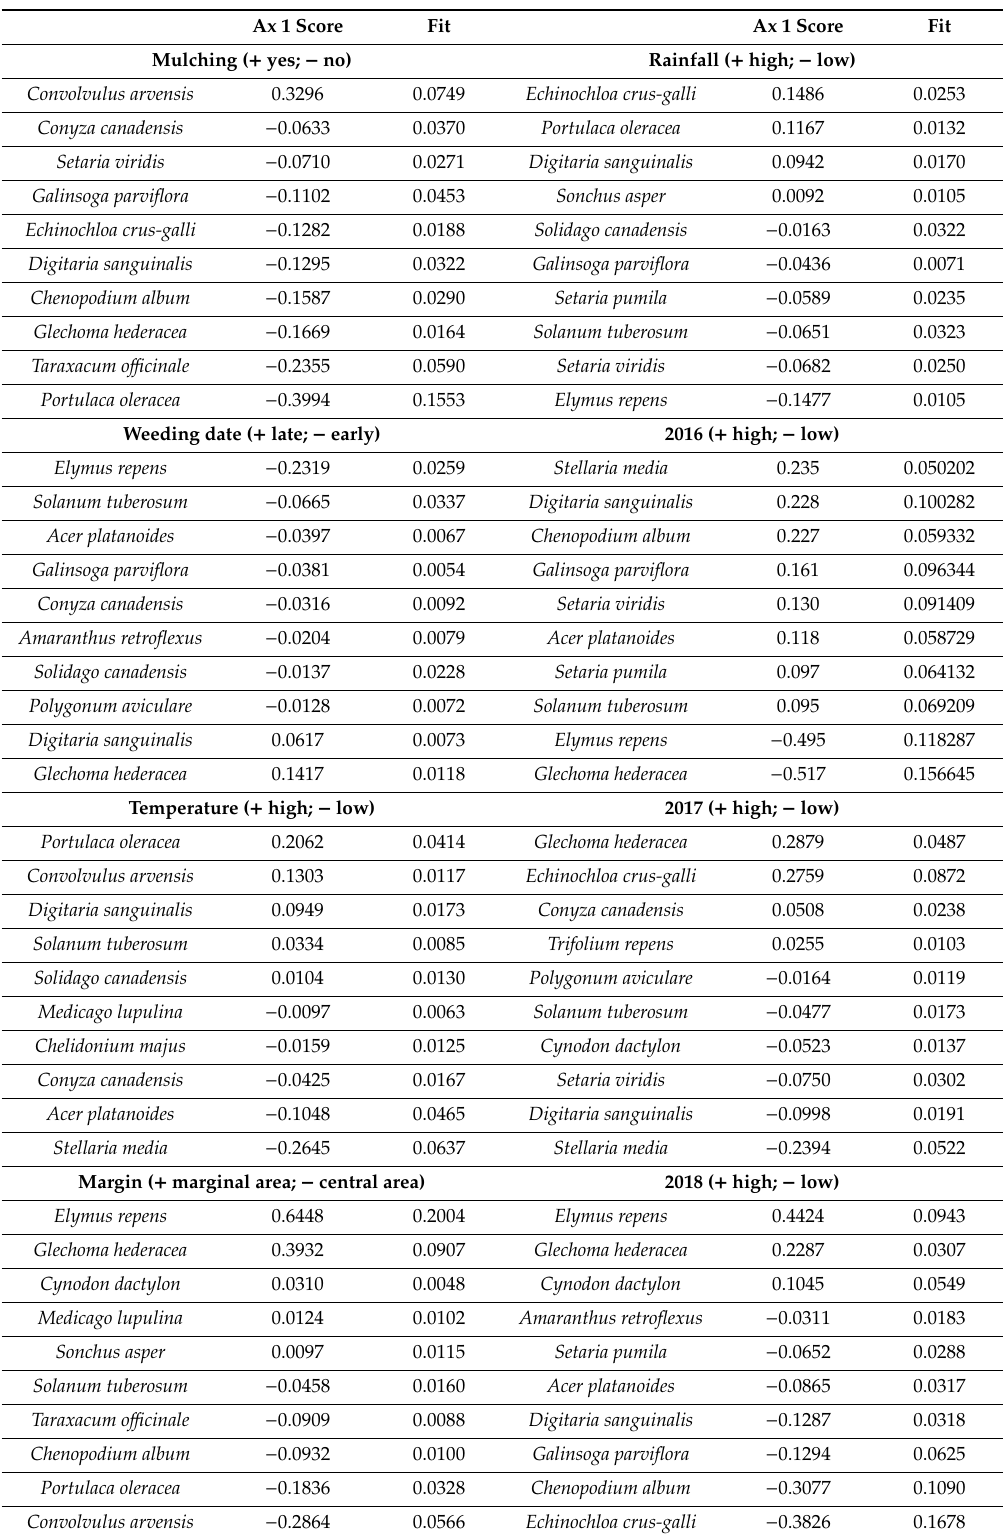
Table 2. Names, score values and fit of species giving the highest fit along the first constrained axis in the partial redundancy analysis (pRDA) models in an open-field tomato experiment (Gödöll˝o, Hungary,